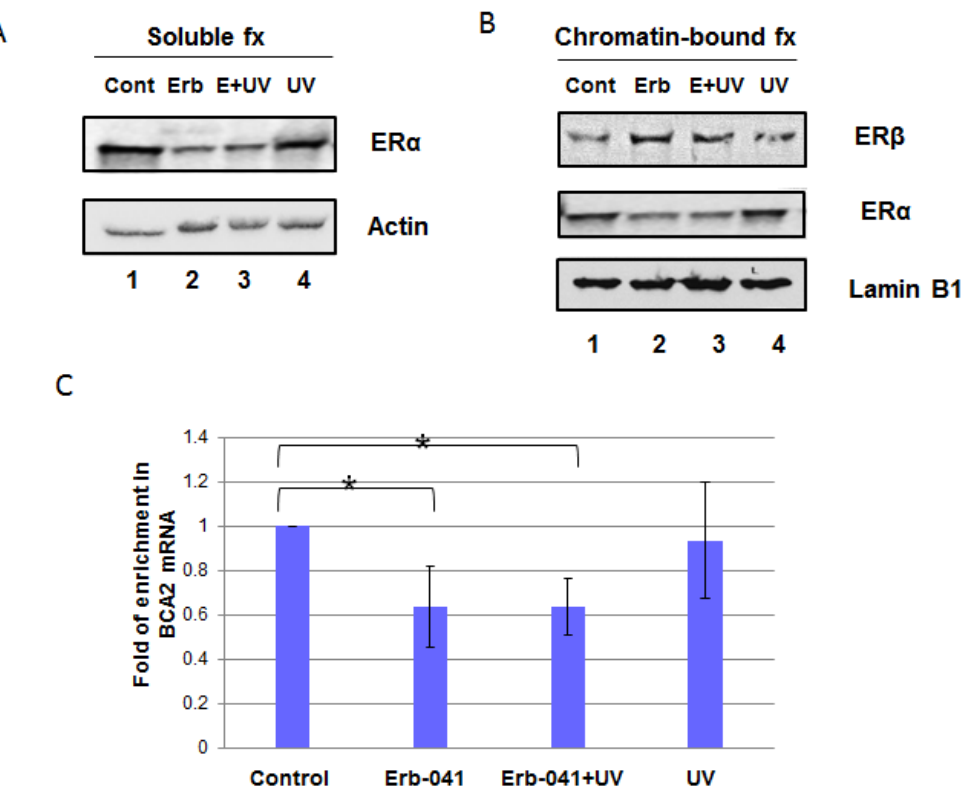
Figure 1. Erb-041 suppressed UVC-induced chromatin association of ERα in response to ERβ upregulation. ( A ) MCF-7 cells were treated with Erb-041 for 24 h prior to irradiation, as indicated in panels ( A – C ). Cell lysates from exponentially growing MCF-7 cells were fractionated into chromatin-bound ( B ) and soluble ( A ) fractions. The samples were subjected to SDS-PAGE electrophoresis and immunoblotting using anti-ERα, ERβ, actin, lamin B1 and β-tubulin antibodies. The latter two blots were set as internal controls for the proteins expressed in the chromatin-bound and soluble fractions; ( C ) The mRNA levels of BCA2 were analyzed using real-time RT-PCR. GAPDH was used as a loading control. The error bars represent standard deviations in this figure, as well as in all the other graphical figures. * denotes significant difference between control and experimental groups with p < 0.05 ( n = 3 for all measurements). Description of experimental conditions: lanes 1, cells without any treatment (denoted by Cont); lanes 2, cells incubated with 40 μg/mL Erb-041 for 24 h (denoted by Erb); lanes 3, cells incubated with 40 μg/mL Erb-041 for 24 h before UVC irradiation at the energy irradiance of 10 J/m 2 (denoted by E+UV); lanes 4, cells irradiated by 10 J/m 2 UVC (denoted by